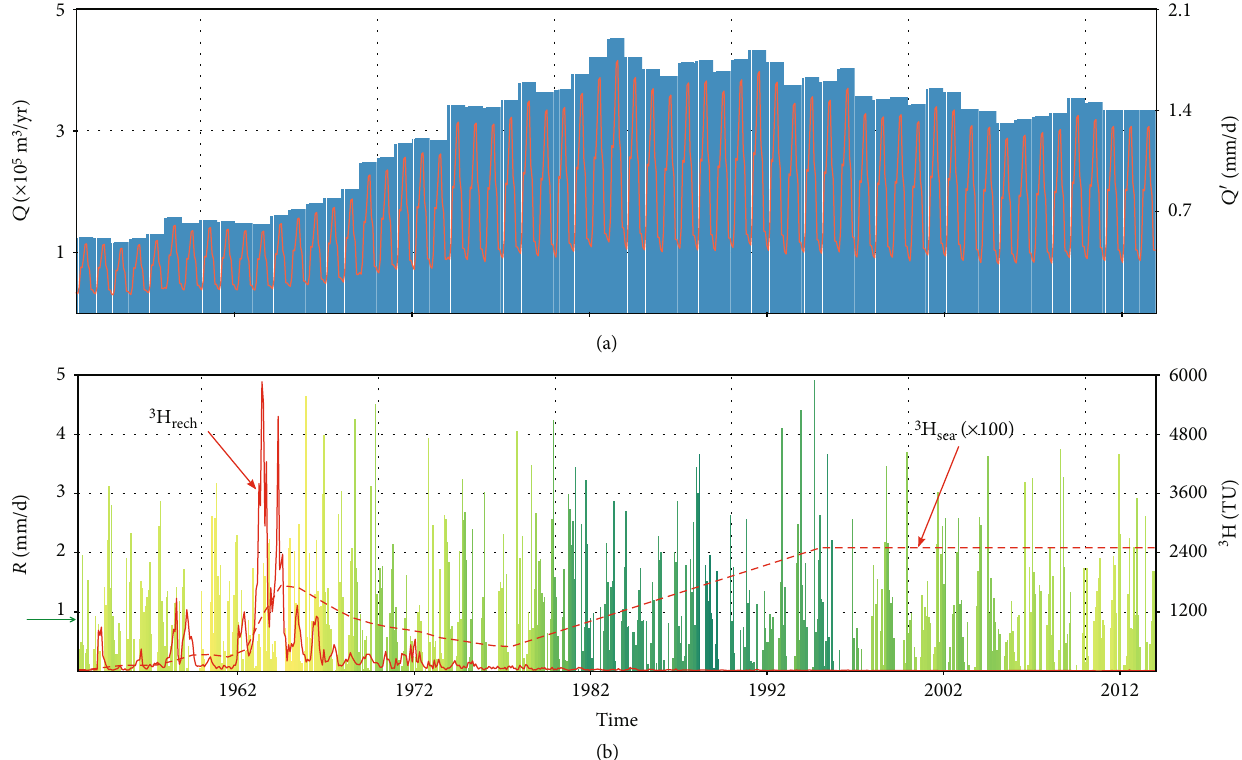
Figure 2: Time series data used in the model: (a) total annual abstraction ( Q ) from the freshwater lens (blue bars) as well as seasonally distributed abstraction per unit of surface area ( Q ′ ) versus time (red line); (b) calculated groundwater recharge ( R , bars) and 3 H , solid red line) and seawater ( 3 H , dashed red line) as a function of time (see text for concentration of groundwater recharge ( 3 H rech sea source of data). The colour of the bars in (b) indicates relatively dry (yellow) or wet (green) phases based on the cumulative deviation from the mean recharge rate. The small green arrow pointing to the y axis in (b) indicates the mean recharge rate ( 0 : 87 mm/d = 319mm/yr ) that was used in simulation